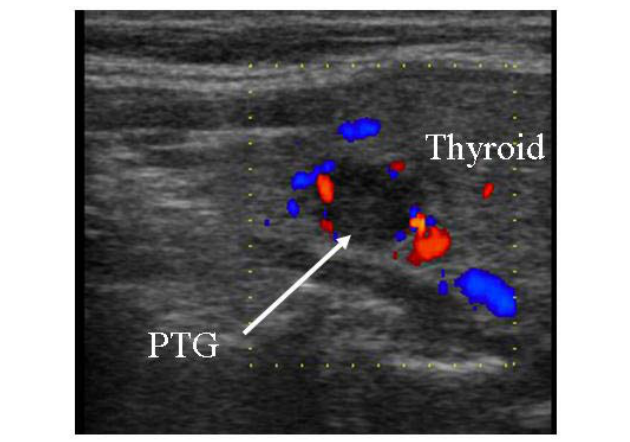
FIGURE 7. PTG with hypervascular capsule in 44-year-old woman, on dialysis treatment 3 years, PTH 912.3 pg/ml (longitudinal section, probe 10 MHz).